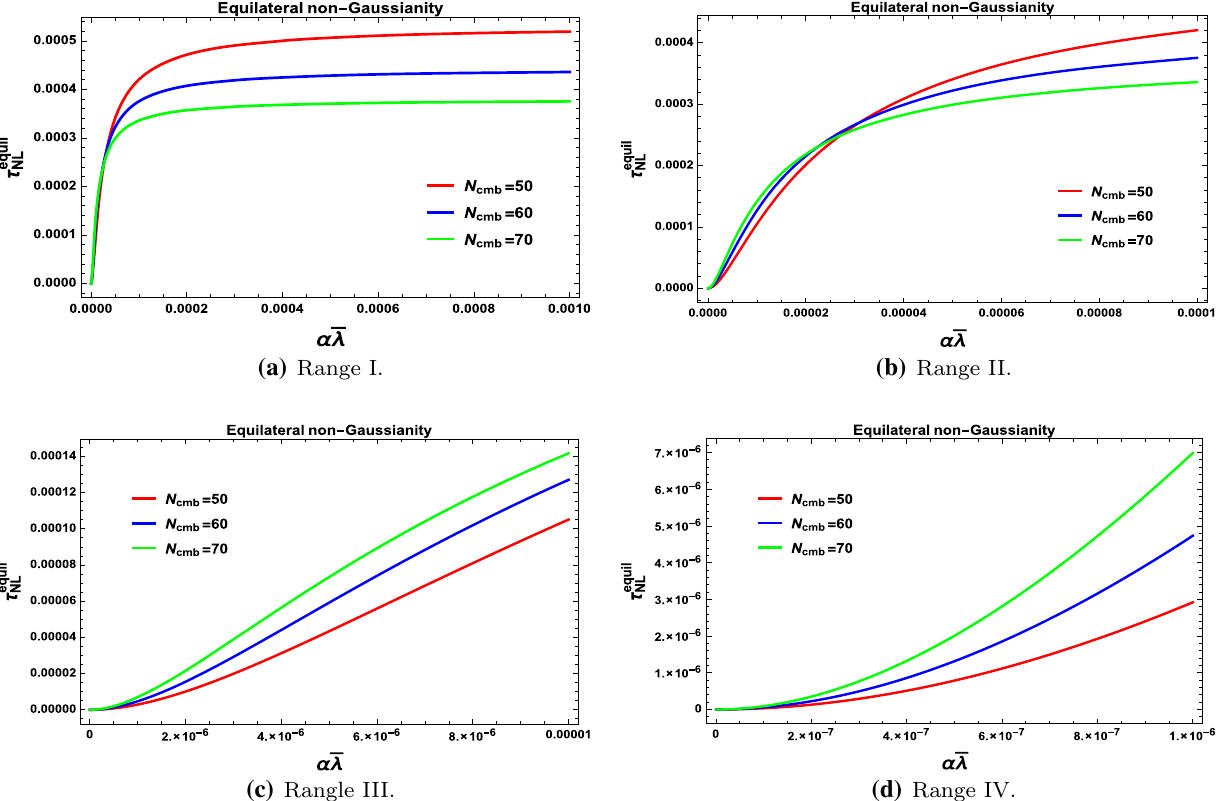
Fig. 20 Representative diagram for equilateral non-Gaussian three point amplitude vs. product of the parameters α ¯ λ in four different regions for = 50 ( red ), N = 60 ( blue ) and N = 70 ( green ) N cmb cmb cmb in four different scanning regions of the product of the ¯ λ , α ¯ λ) and ( g equil , α ¯ λ) 2D two parameters α in the (τ equil NL NL plane for the number of e-foldings 50 < N cmb <